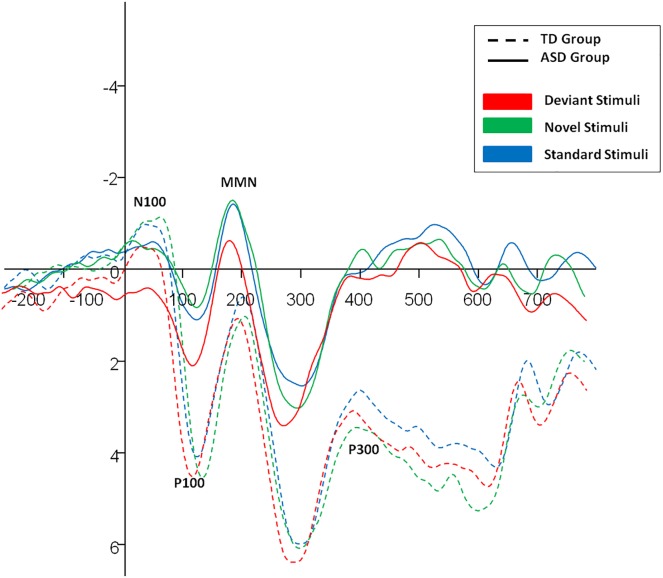
Average P100, N100, MMN and P300 ERPs in response to three image types in the ASD and TD groups.